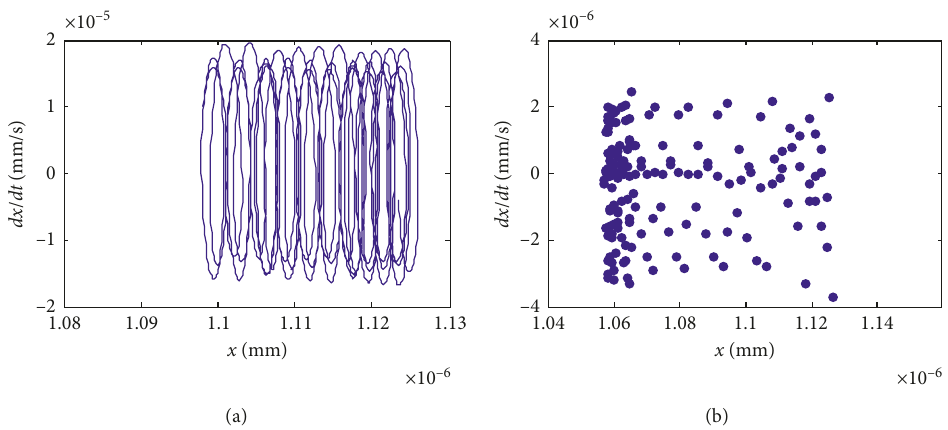
Figure 4: System response for ω � 10000r/min. (a) Phase portraits. (b) Poincar´e